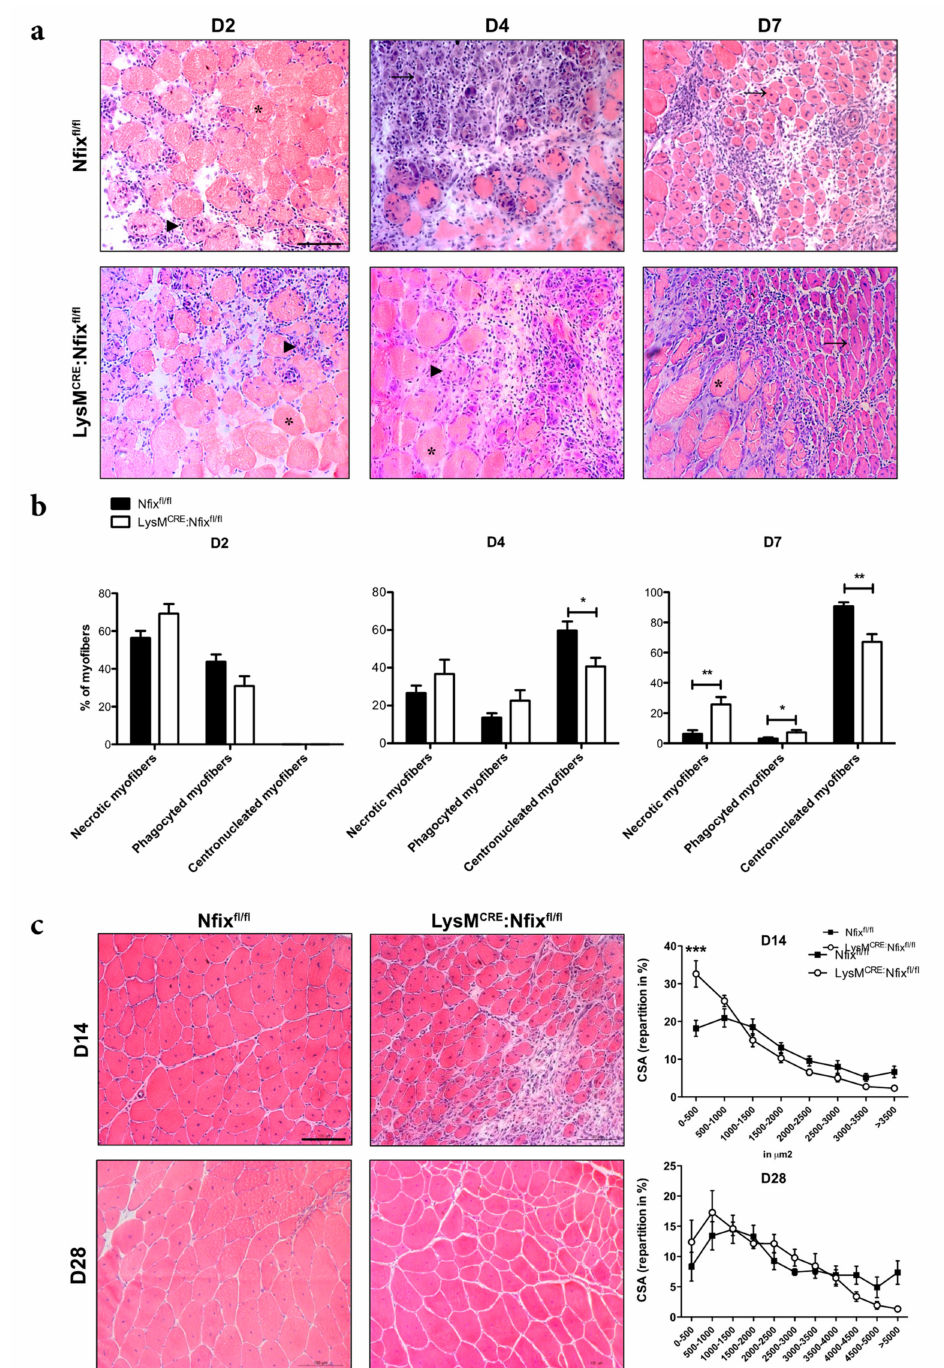
Figure 2. Lack of Nfix in MPs induces a delay of skeletal muscle regeneration. ( a ) Hematoxylin-eosin staining of Nfix fl / fl and LysM CRE :Nfix fl / fl TA muscles injected by CTX at D2, D4, D7 postinjury; ( b ) Quantification of necrotic (asterisk), phagocyted (arrowhead) and centrally-nucleated (arrow) myofibers, expressed as percentage out of total myofibers; ( c ) Hematoxylin-eosin staining of Nfix fl /